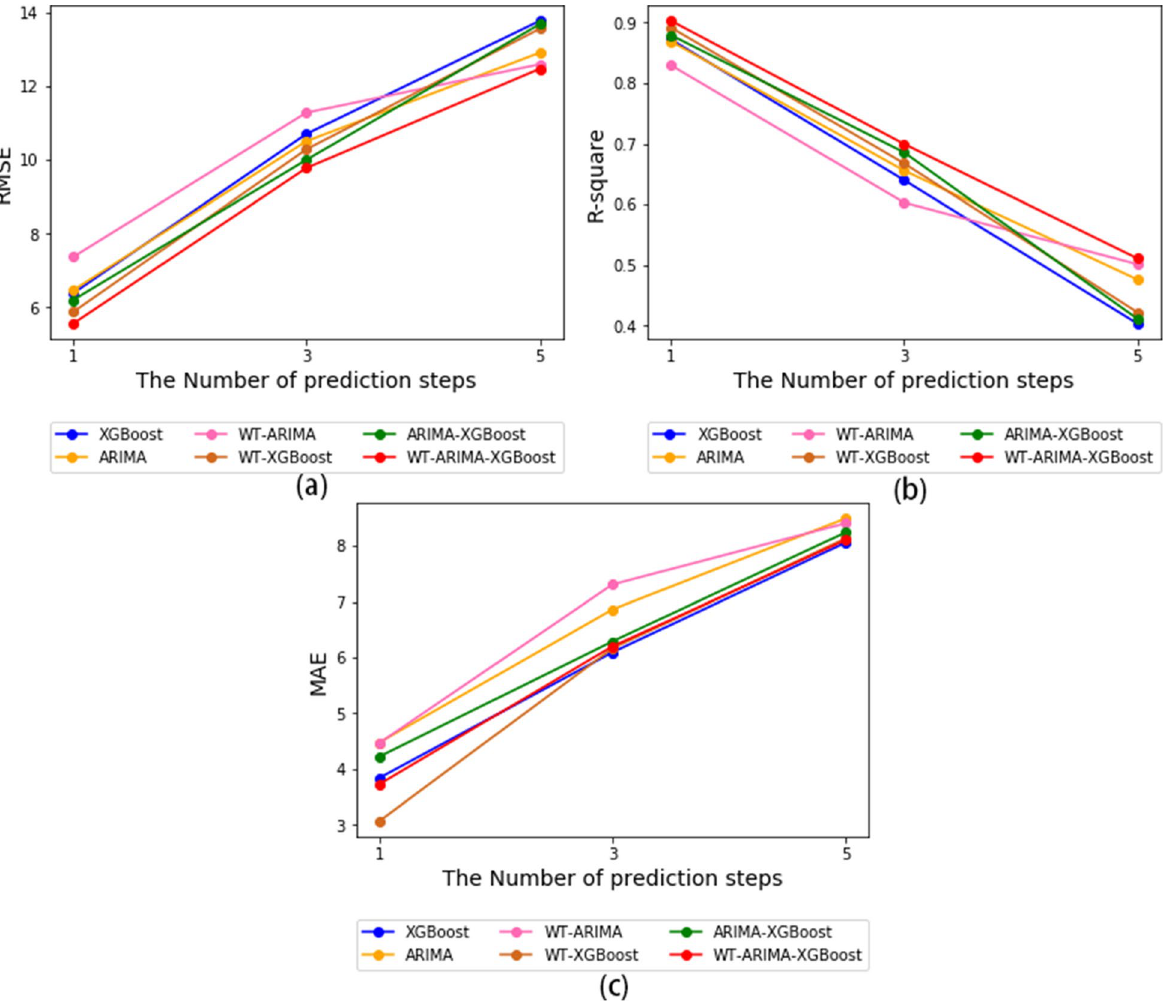
Fig. 8 Comparison of multistep prediction accuracy using tested models